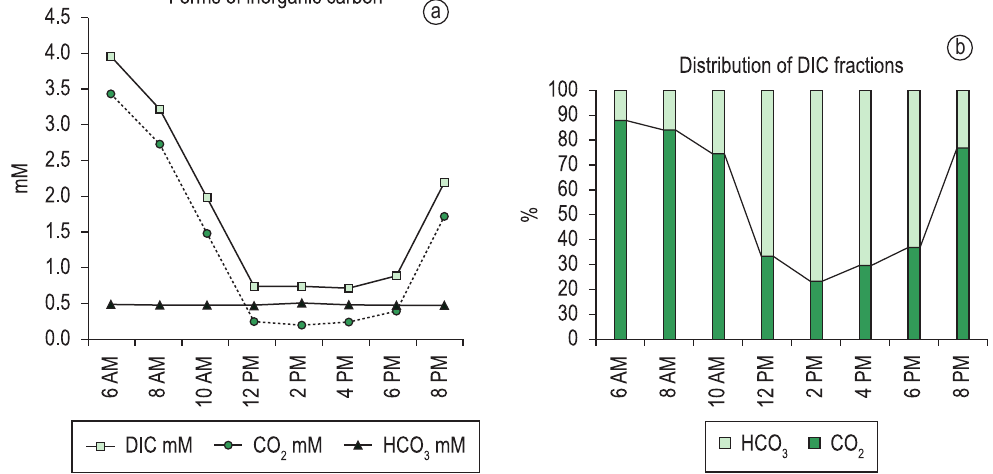
Figure 1. Diurnal variations in the forms of inorganic carbon. DIC values are highly influenced by fraction CO (a), however fraction HCO prevails in the period between 12:00 PM and 6:00 3-